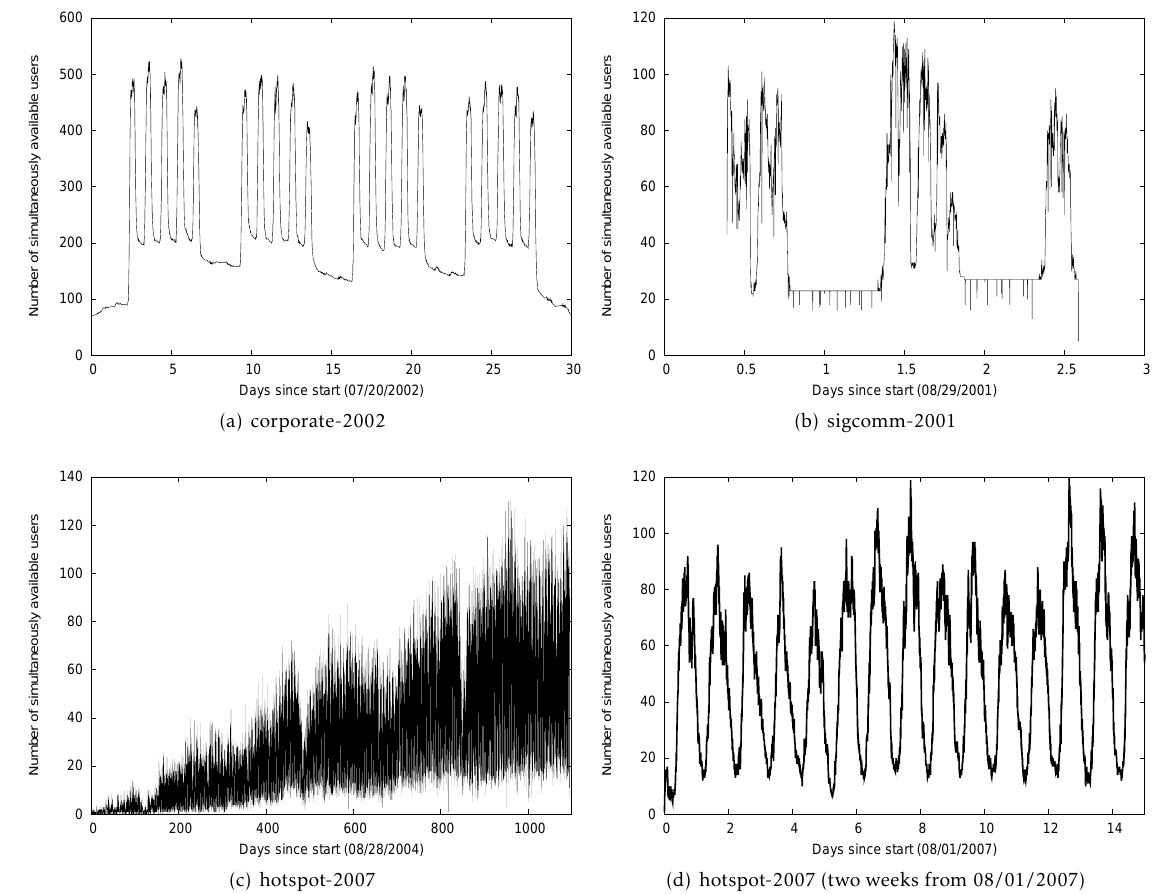
Figure 2. Number of simultaneously available users